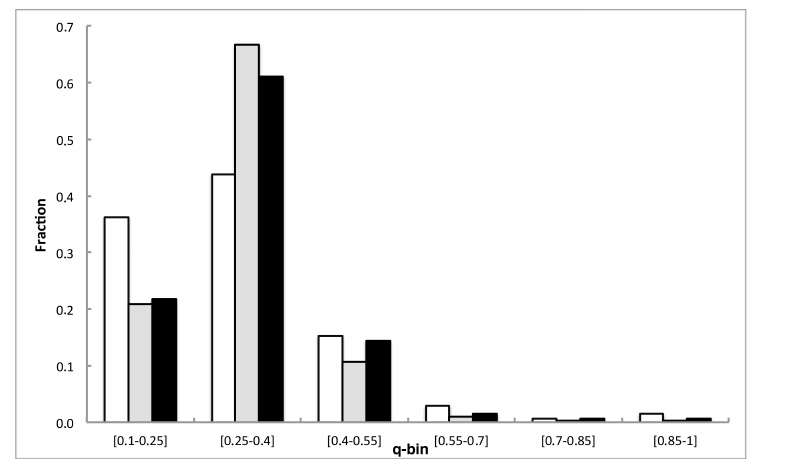
Figure 3. The observed distribution of the mass ratio for 351 Algols (white) as compared to conserva- tive (grey) and liberal (black) simulation.